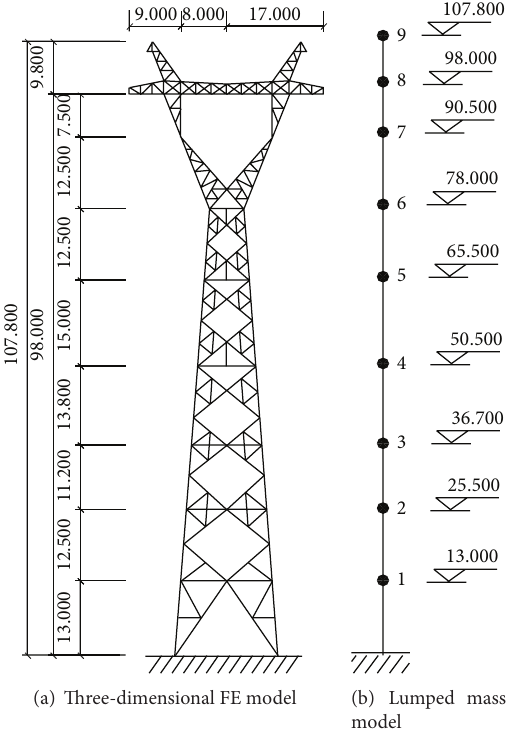
Figure 1: Analytical model of a transmission